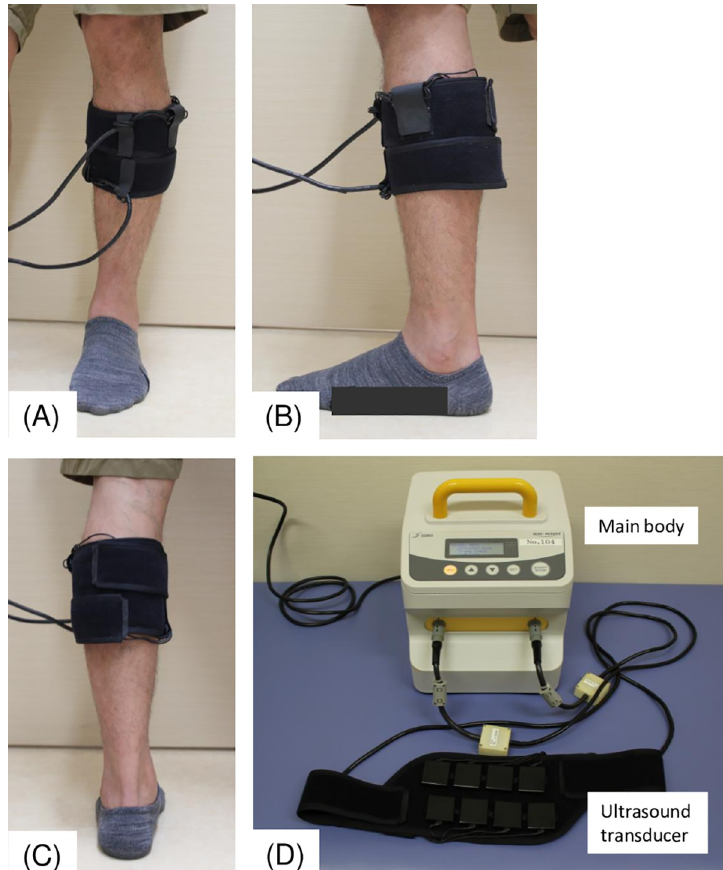
Fig 1. The LIPUS system set-up. (A) Application of transducers for LIPUS exposure in the gastrocnemius of the ischemic leg (anterior view). (B) Application of transducers for LIPUS exposure in the gastrocnemius of the ischemic leg (lateral view). (C) Application of transducers for LIPUS exposure in the gastrocnemius of the ischemic leg (posterior view). (D) Appearance of the low-intensity pulsed ultrasound (LIPUS)